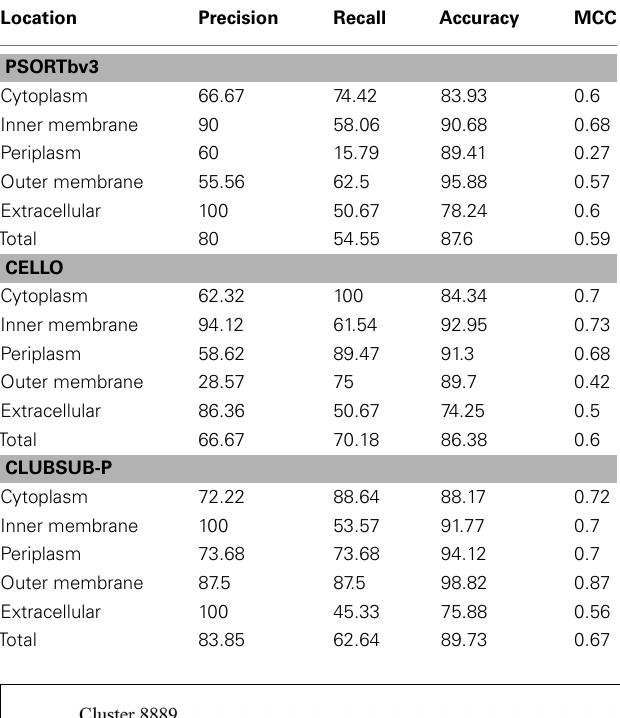
bacterial subcellular localization prediction tools.